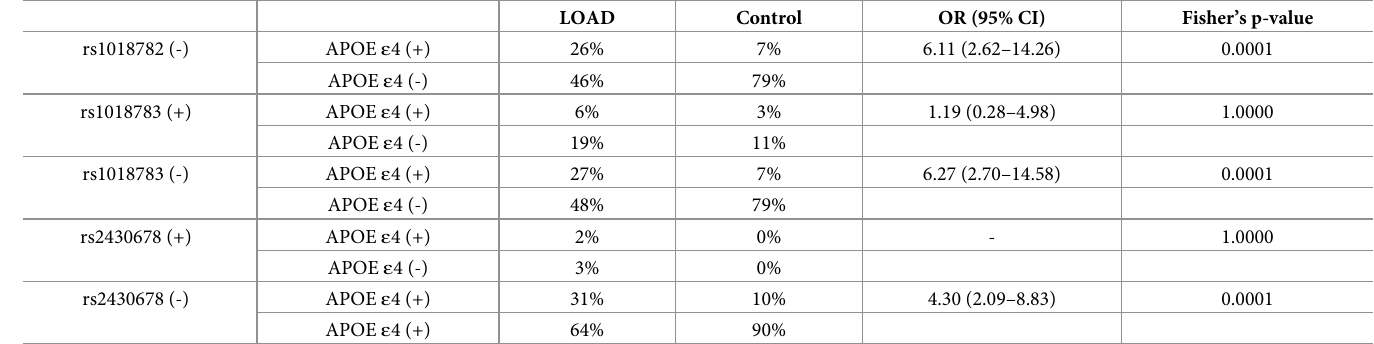
of each postmortem brain tissue for LOAD (10 samples for each region), cognitively normal controls (9 samples for each region) and hpC group (8 samples for each region) (Table 9). No statistically significant differences (p < 0.05) were found between UNG and NEIL1 allele and